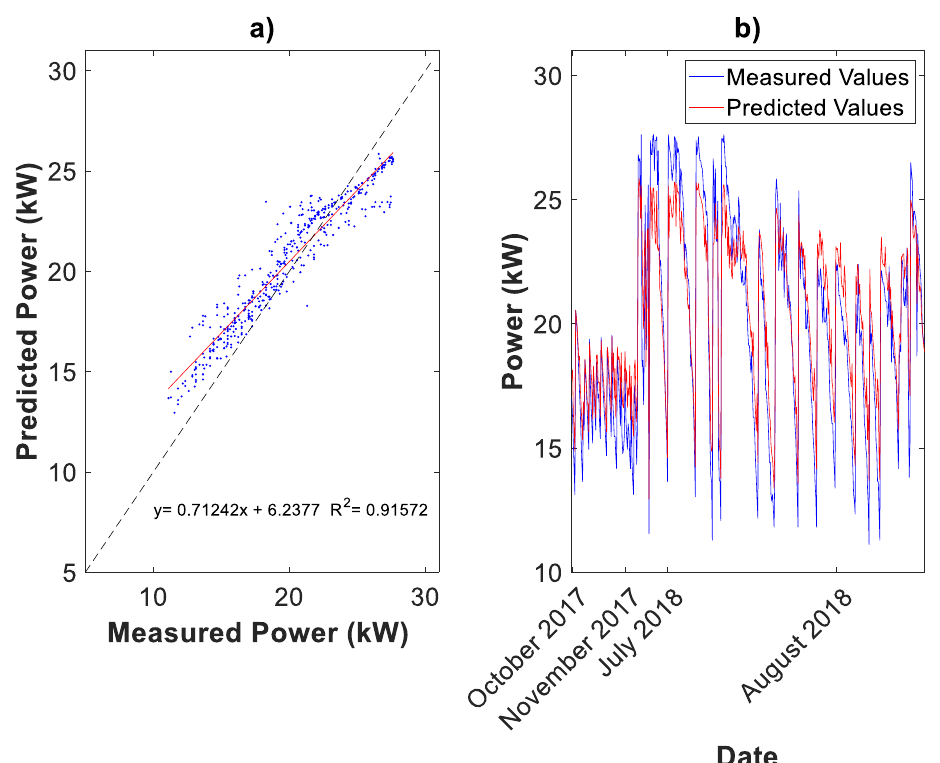
Figure 6. ( a ) Statistical analysis of the PREPOSOL model and ( b ) Comparative between the measured Figure 6. a ) Statistical analysis of the PREPOSOL model and b ) Comparative between the meas- ured values and the predicted values. values and the predicted values. Table 2. Individual irrigation strategy.